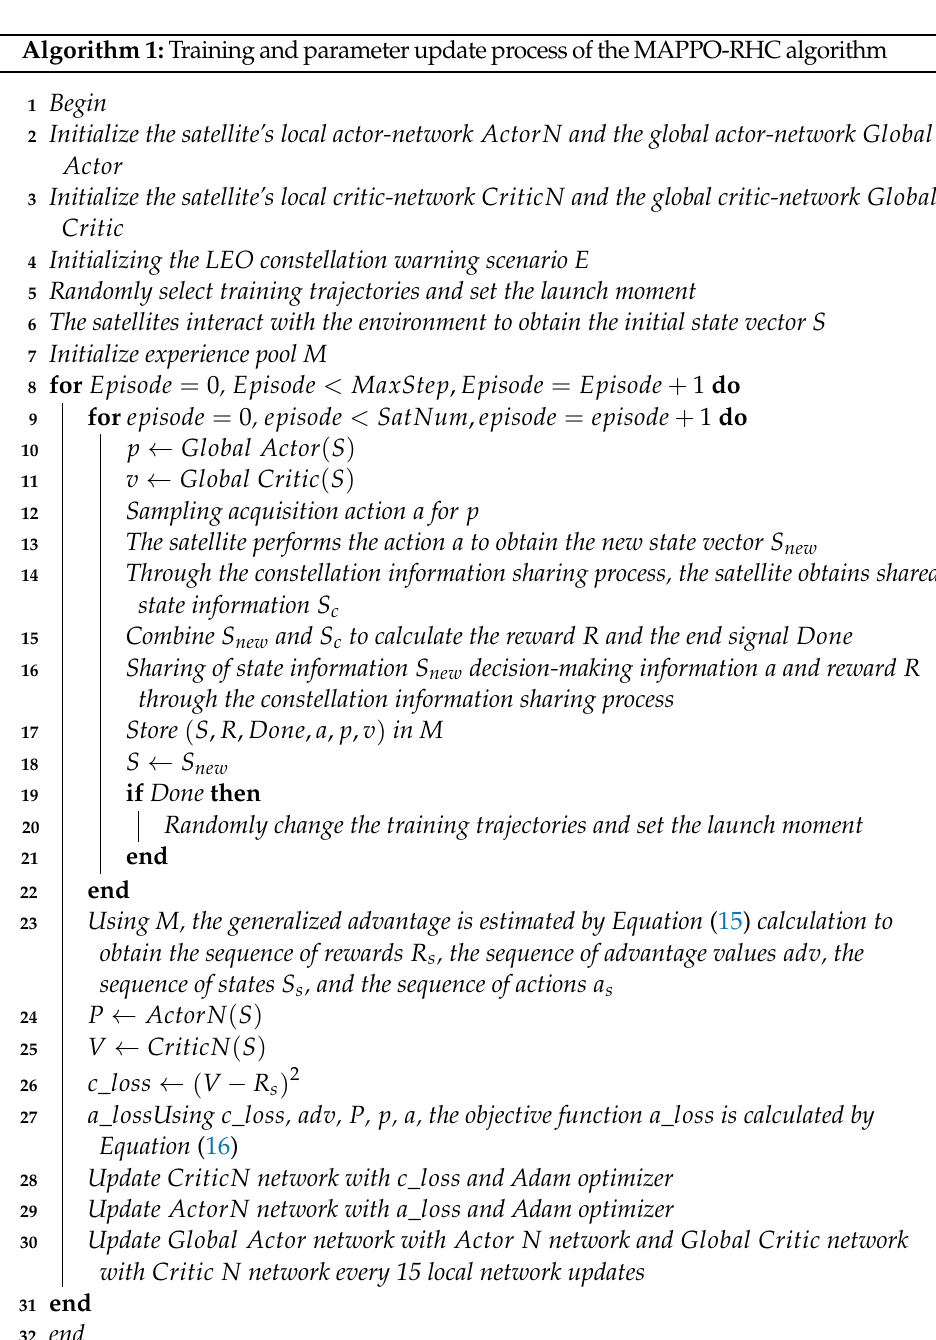
Algorithm 1: Training and parameter update process of the MAPPO-RHC